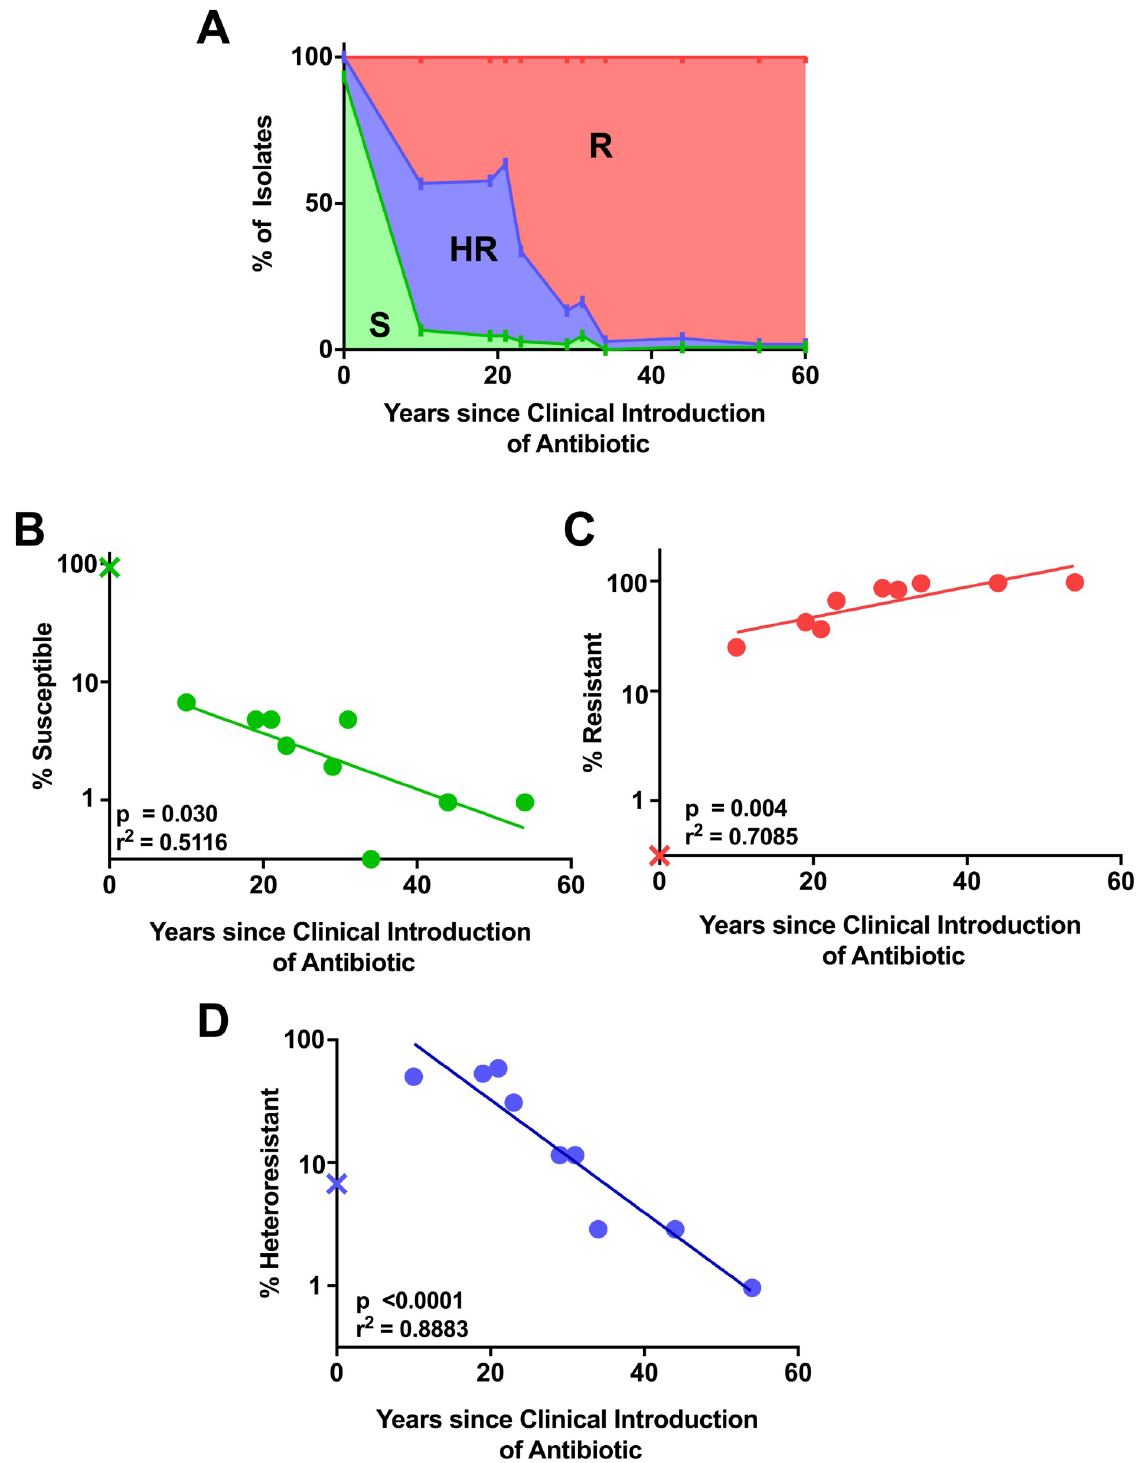
Fig 1. Incidence of heteroresistance and resistance correlates with number of years of clinical use of beta-lactam antibiotics. (A) A AU : PerPLOSstyle ; numeralsarenotallowedatthebeginningofasentence : Pleaseconfirmthattheeditstothesentence ð A Þ Atotalof 104 isolatesofCREfromGeorgia ::: inFigs 1 and 2 arecorrect ; andamendifnecessary : total of 104 isolates of CRE from Georgia area hospitals were assayed for heteroresistance, resistance, and susceptibility to 10 beta-lactam antibiotics that were introduced clinically in different years (ampicillin, 1961; cefazolin, 1971; amoxicillin/clavulanate, 1981; ceftazidime, 1984; aztreonam, 1986; piperacillin/tazobactam, 1992; cefepime, 1994; meropenem, 1996; doripenem, 2005; and ceftazidime/avibactam, 2015). Percent incidence of each designation was plotted by the age of the drug. Green area, susceptible (S); red area, resistant (R); blue area,